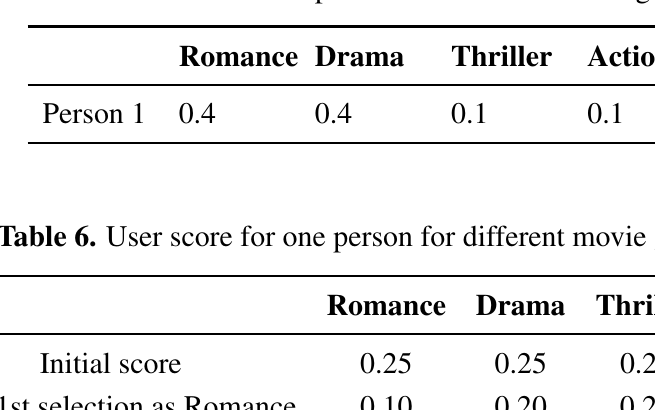
Table 5. Prior score of a person for different movie genres.